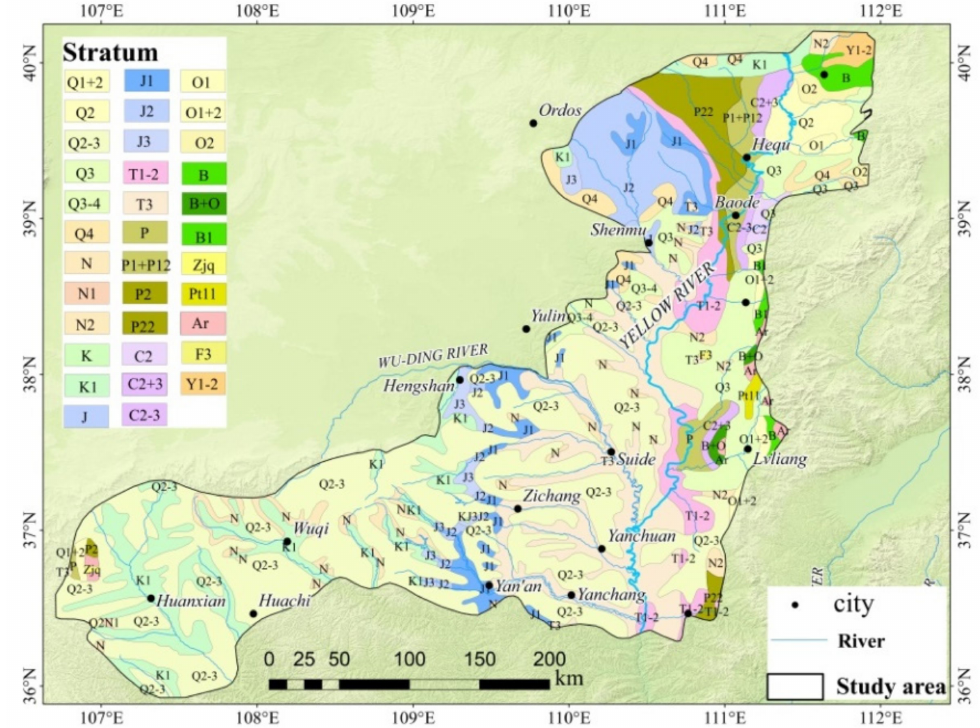
Figure 2. Geological map of the study area (Q: Quaternary system (Q1: Wu-cheng loess